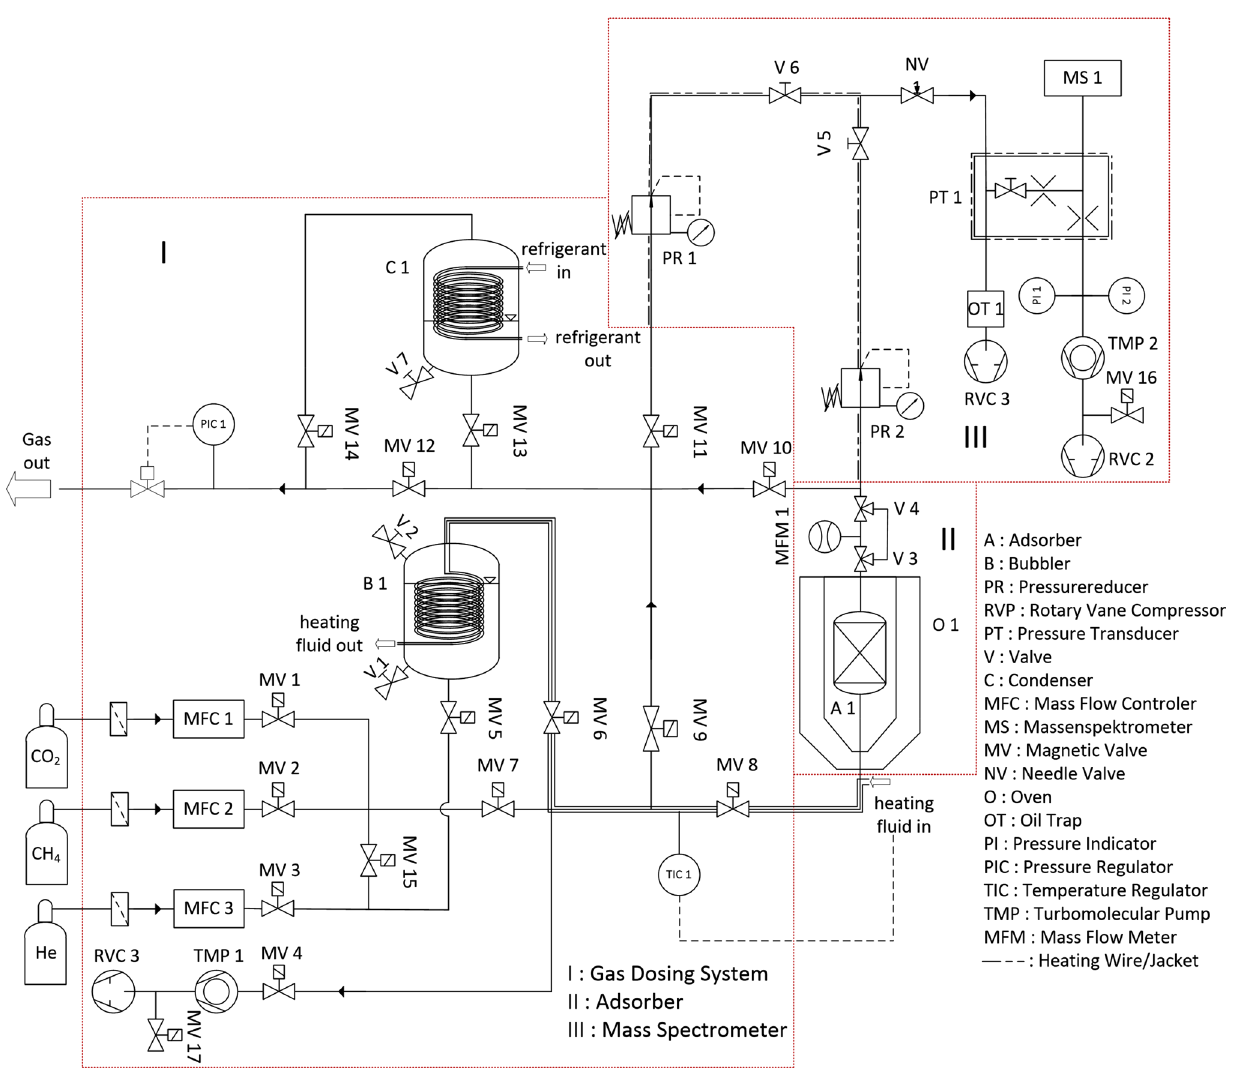
Fig. 6 Flow chart of the breakthrough plant including gas dosing system (I), adsorber (II), gas analysis